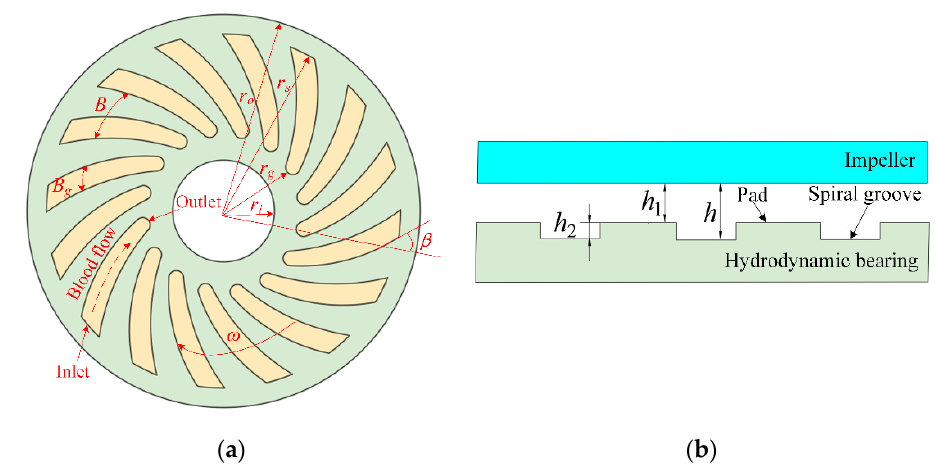
Figure 10. Structure composition of the hydrodynamic bearing: ( a ) Structural parameters of the hydrodynamic bearing; ( b ) Cross ‐ sectional view of the hydrodynamic bearing.